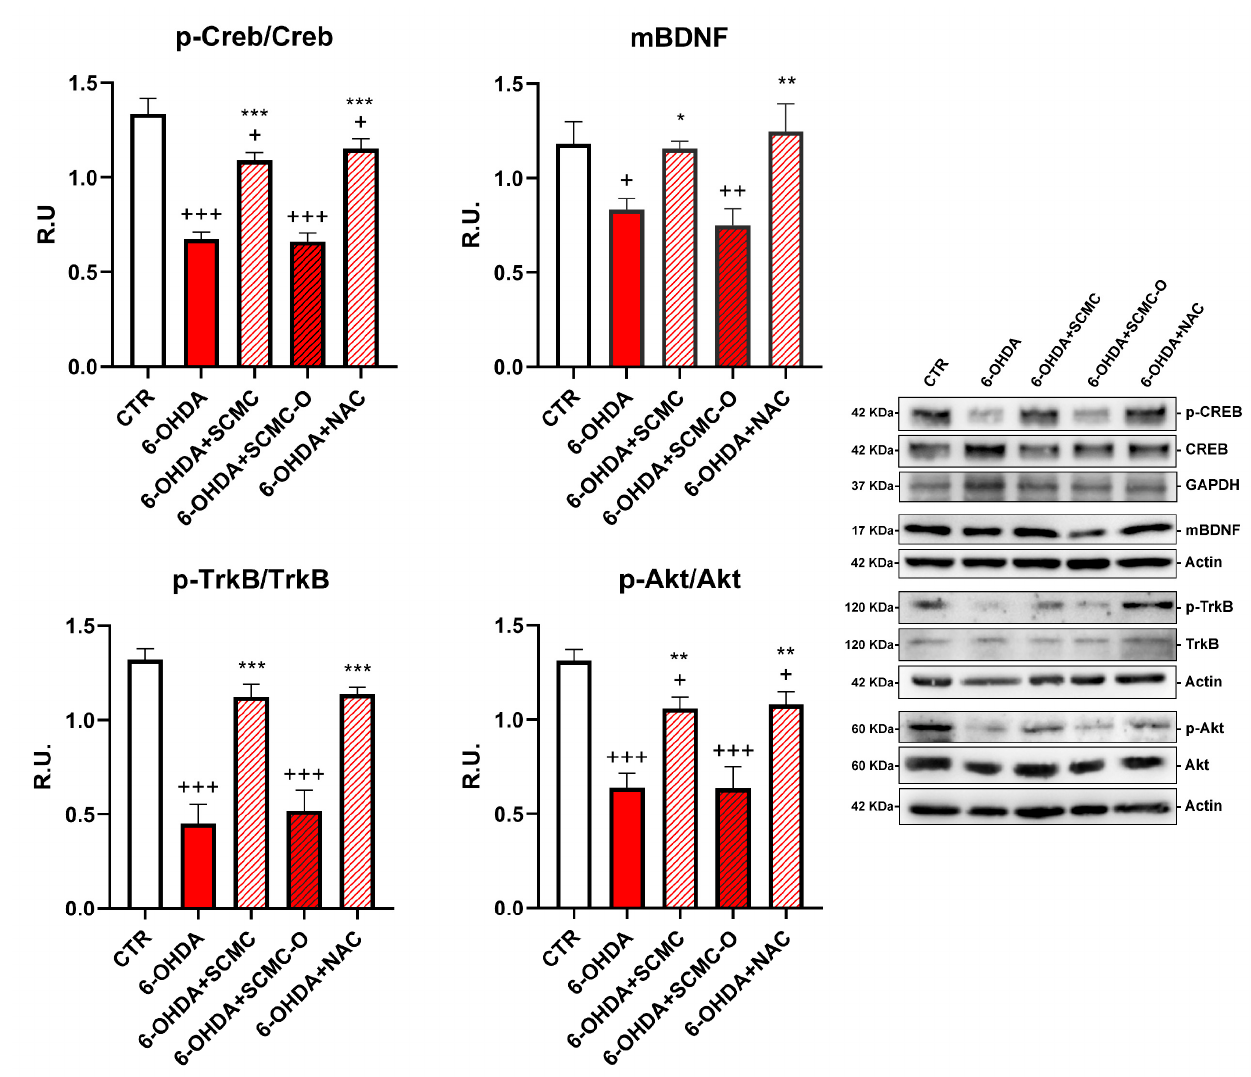
Figure 3. WB analyses for the neuroprotective pathways p-Creb, mBDNF, p-AKT, and p-TrkB. Data are mean ± SE of three different experiments; *: p < 0.05; **: p < 0.005, ***: p < 0.0001 vs. 6-OHDA; +: p < 0.05; ++: p < 0.005, +++: p < 0.0001 vs. CTR.